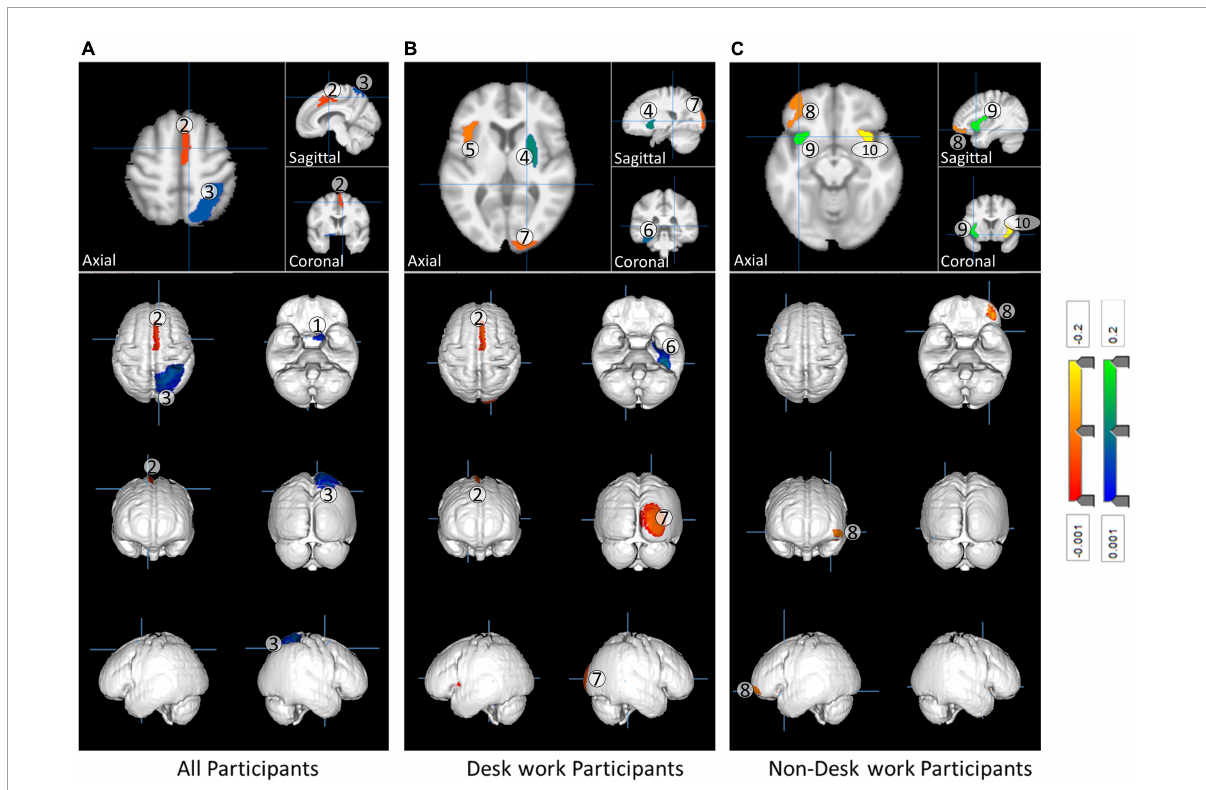
FIGURE4 The impact of fatigue on gray matter volume in the participants. (A) All participants, (B) desk work participants, and (C) non-desk work participants. The most significant regions presented in Table 2 are color-coded based on Beta (B) values with red as a negative change and blue as a positive change. The rGMVs index in the figure follow the index presented in Table 2